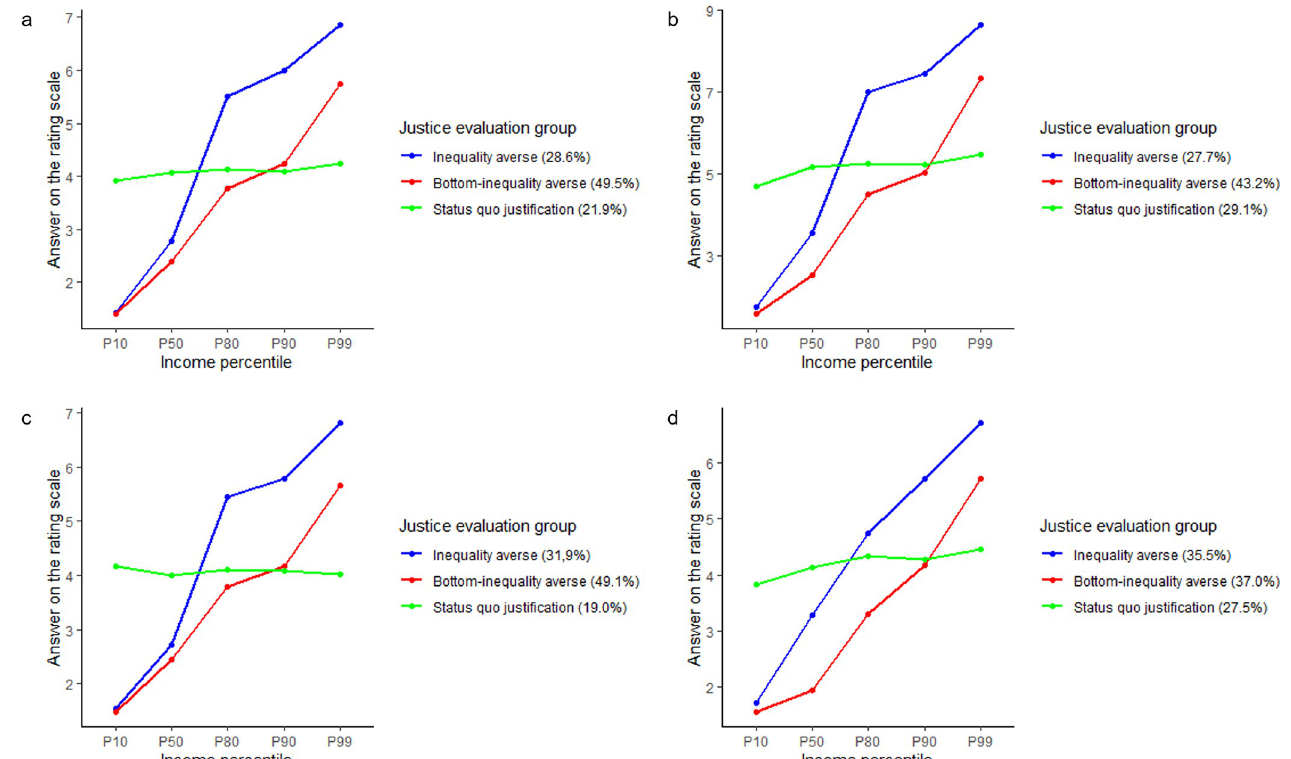
Fig 3. Average answers of the extracted clusters by study. Note . a: Study 1. The rating scale ranged from 1 ( unfairly low ) to 7 ( unfairly high ). n Inequality averse = 139, n Bottom-inequality averse = 240, n Status quo justification = 106. b: Study 2. The rating scale ranged from 1 ( unfairly low ) to 9 ( unfairly high ). n Inequality averse = 171, n Bottom-inequality averse = 267, n Status quo justification = 180. c: Study 3 (Germany). The rating scale ranged from 1 ( unfairly low ) to 7 ( unfairly high ). n Inequality averse = 134, n Bottom-inequality averse = 206, n Status quo justification = 80. d: Study 3 (UK). The rating scale ranged from 1 ( unfairly low ) to 7 ( unfairly high ). n Inequality averse = 156, n Bottom-inequality averse = 163, n Status quo justification =